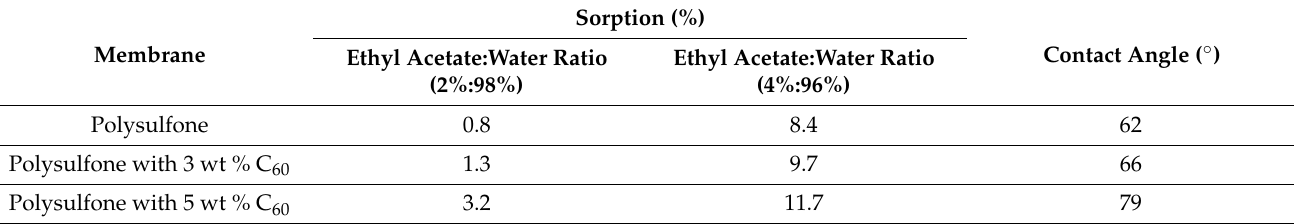
Table 2. Sorption characteristics and contact angles of polysulfone and polysulfone/fullerene C 60 dense membranes [179]. Reproduced with permission from